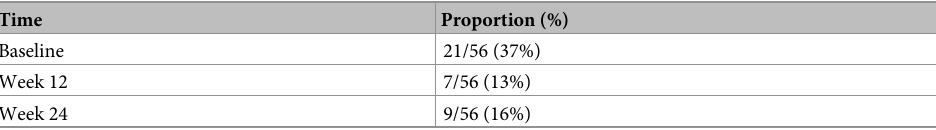
Table 9. Steroid use across